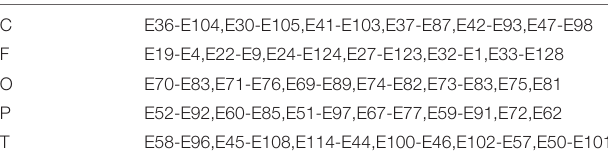
TABLE 2 | Channels in different brain regions are